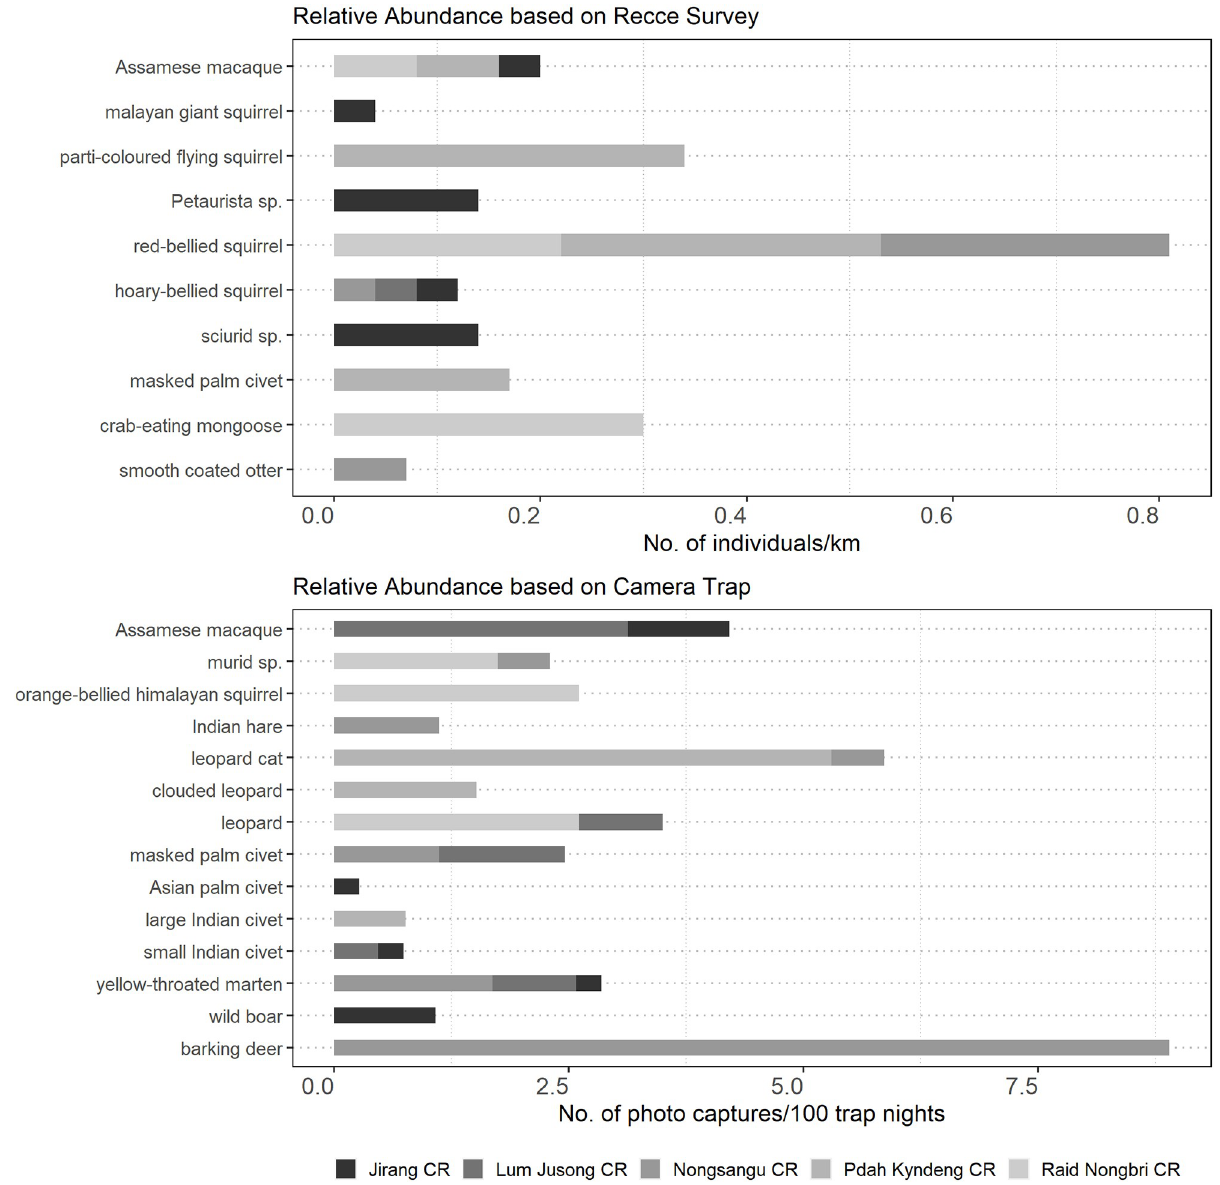
Fig 3. Relative abundance of mammals (no. of individuals/km) during both day-time and night-time surveys as well as for camera trapping (CR = animals/100 trap night) of all species in the Community Reserves of Ri Bhoi district.